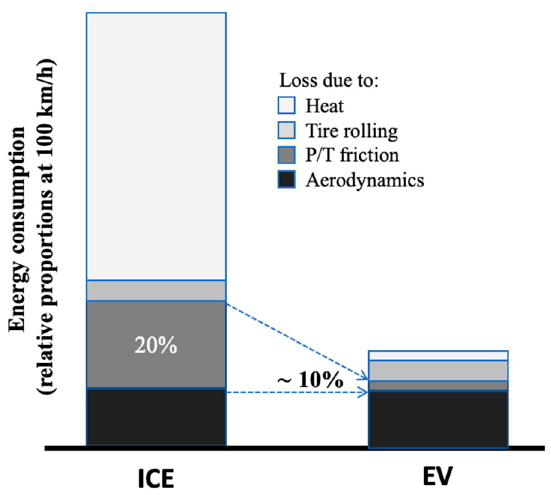
Figure 1. Comparison of energy consumption loss between ICE vehicle and EV (adapted from Kawamata et al. [3]).